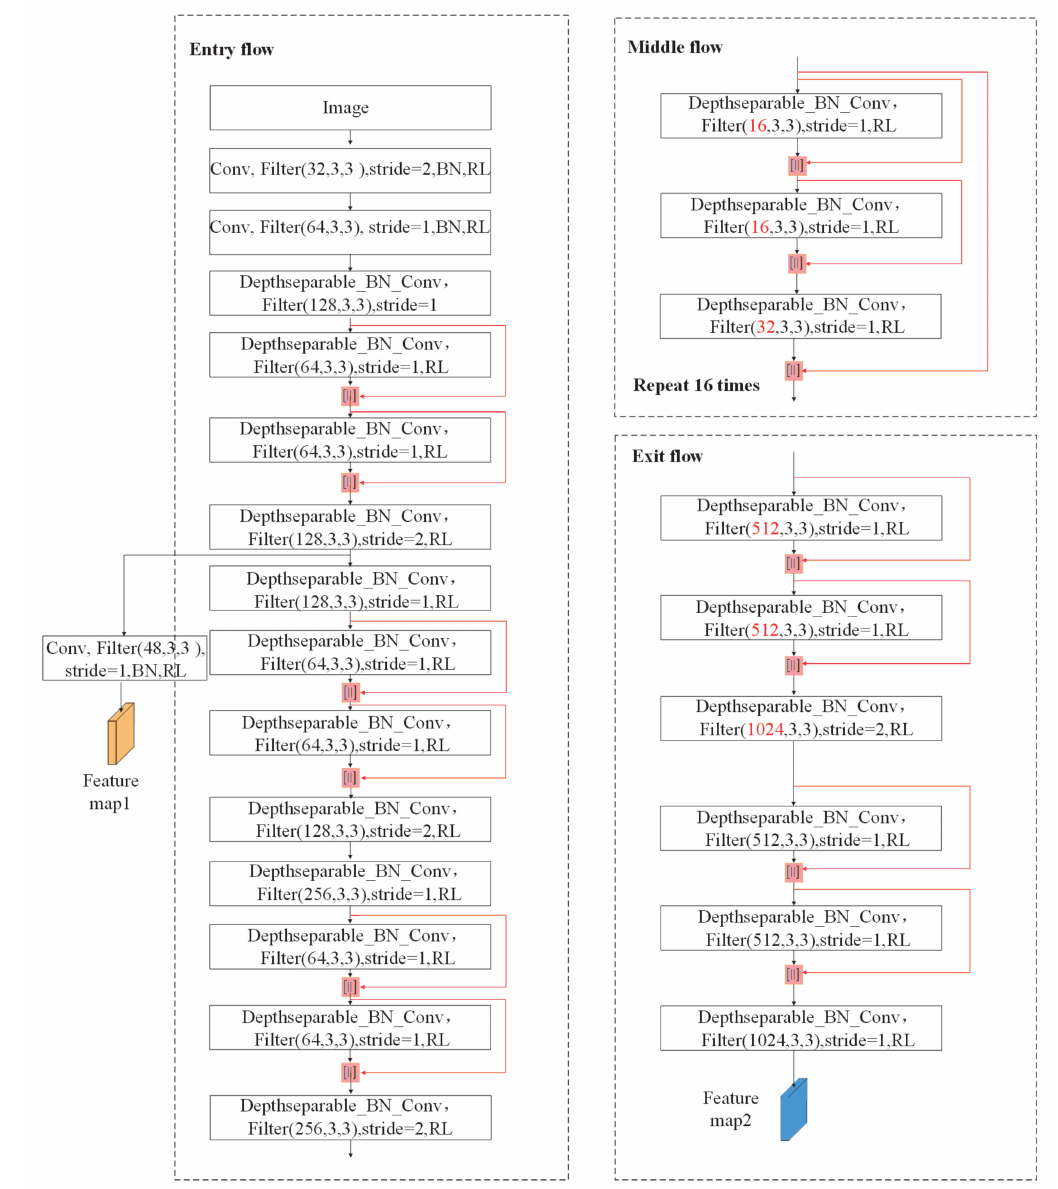
Figure 3. The structure of Dense xception module